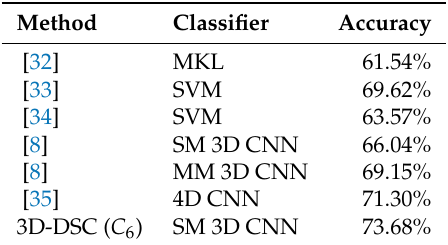
Table 4. Diagnosis performance comparisons between the proposed method and state-of-the-art